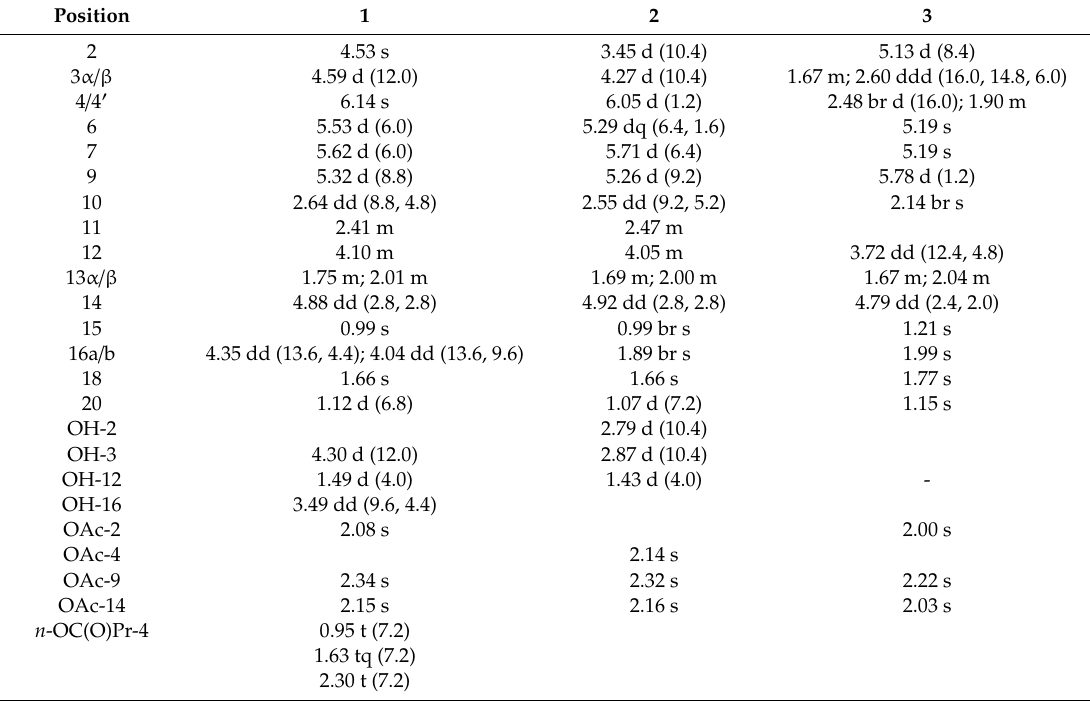
Table 2. 1 H NMR ( δ H , 400 MHz in CDCl 3 ) data ( J in Hz) for briaranes 1 – 3